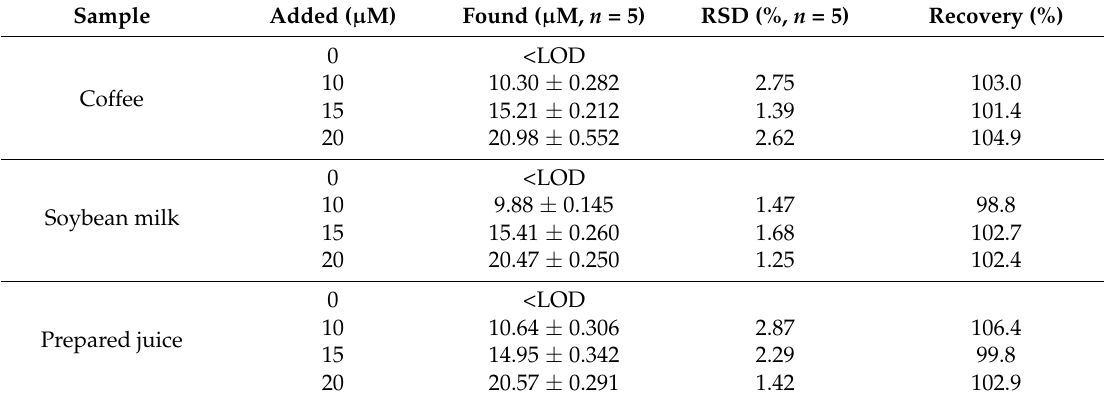
s1, Table S1: Analytical results of BPA in the presence of interfering substances, Figure S1: CVs of (a) bare electrode, (b) rGO/GCE and (c) MoSe 2 /rGO/GCE in 5 mM [Fe(CN)6] 3 − /4 − containing 0.1 M KCl at a scan rate of 100 mV/s, Figure S2: Confirmation of bisphenol A in orange juice by